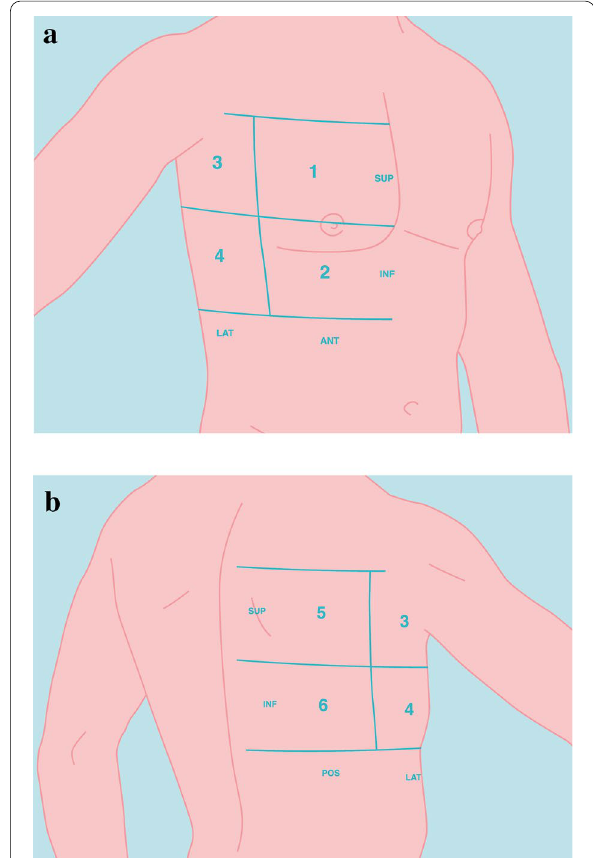
Fig. 1 Each hemithorax is divided in six regions: two anterior, two lateral, and two posteriors, following to anatomical landmarks set by parasternal, anterior and posterior axillary lines. Each region is divided in superior and inferior. To perform an examination, adjacent intercostal spaces are explored in each region of interest, sliding the probe along intercostal